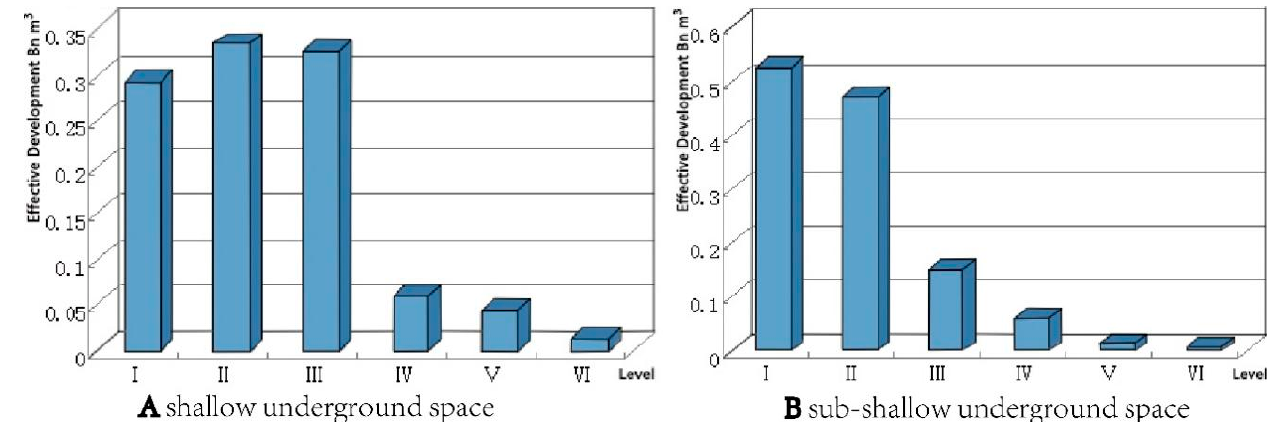
Figure 14. Distribution of effective development capacity of USR for Yangzhou city (( A ) is shallow underground space and ( B ) is sub-shallow underground space).